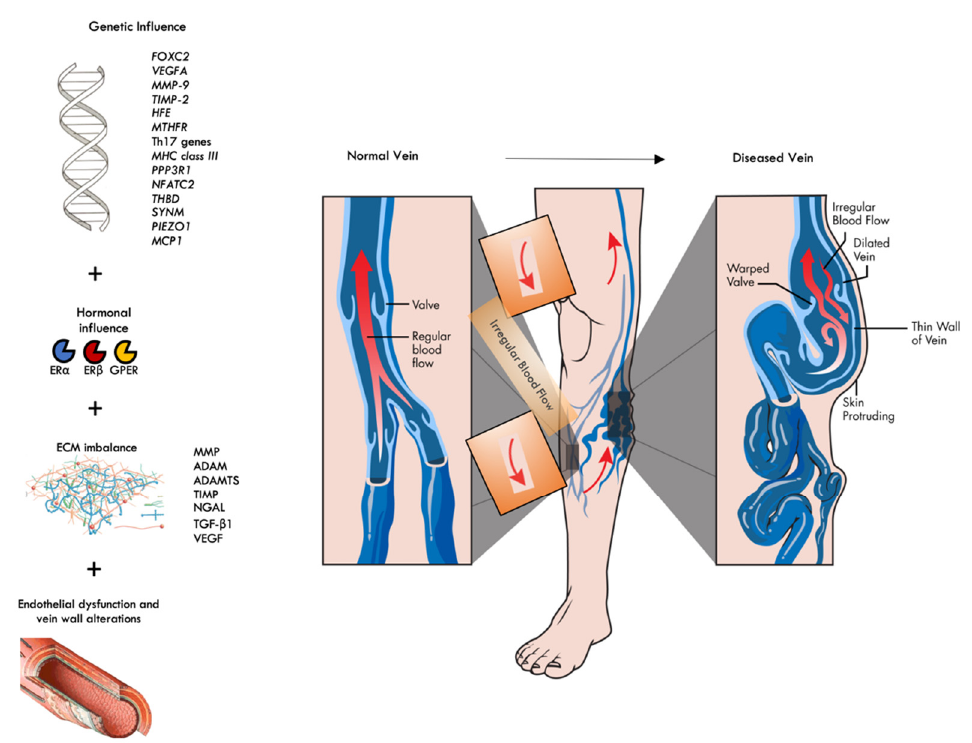
Figure 1. Main pathophysiological mechanisms in CVD development.